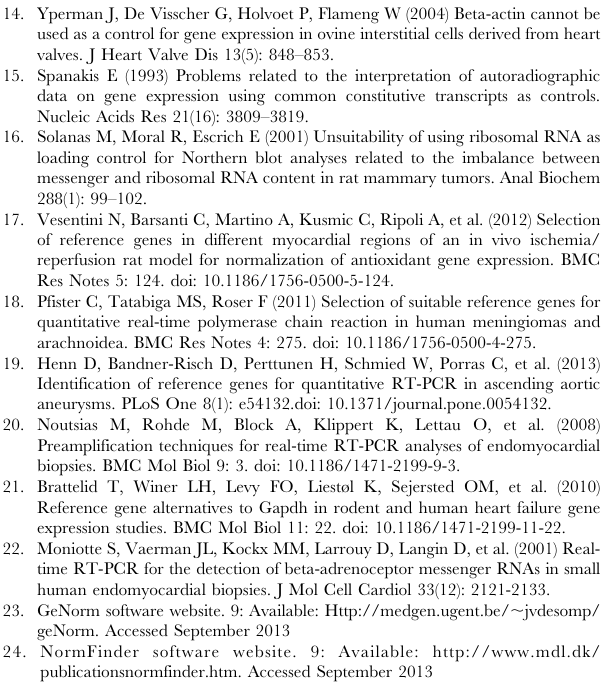
Figure S2 Representative image of a denaturing aga- rose gel to check RNA integrity. Two bright bands